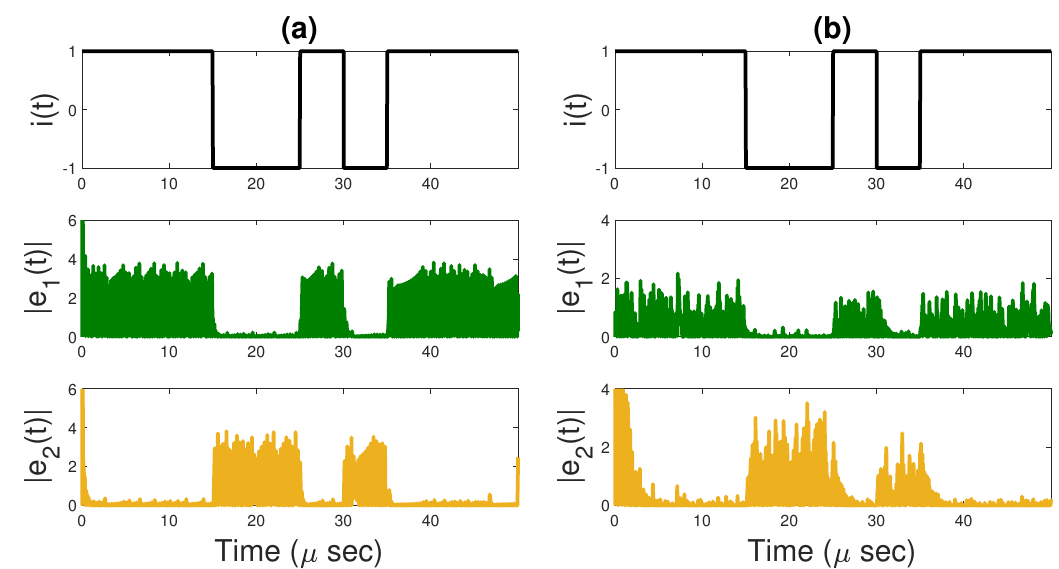
Figure 6. Encoded information and errors | e 1 ( t ) | and | e 2 ( t ) | for ( a ) the Lorenz CBFM waveform and ( b ) Burke–Shaw CBFM waveform. (Illustration purpose only. For practical reasons, a single CBFM pulse transmits only one bit of information.)